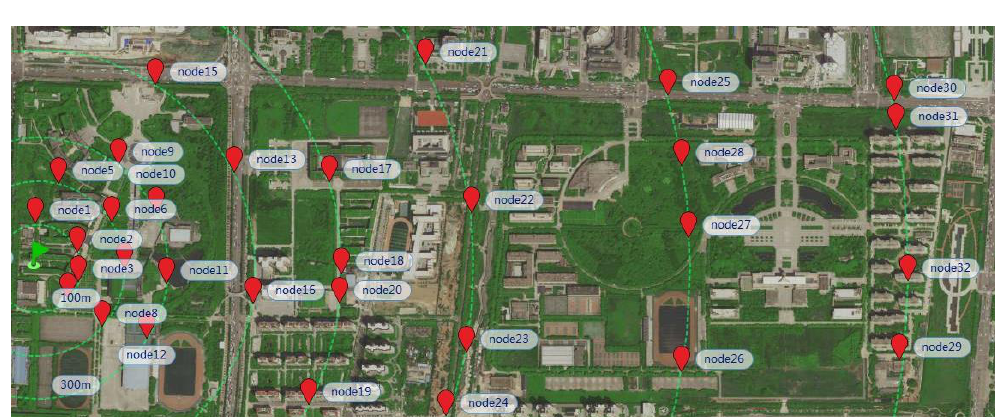
Figure 15. Multi-ED location distribution.